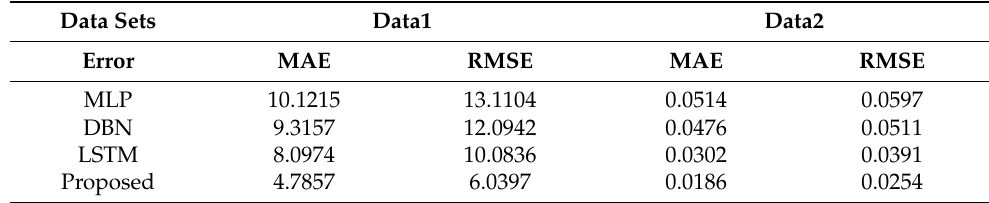
Table 2. Comparison of prediction results of various methods under different data sets.